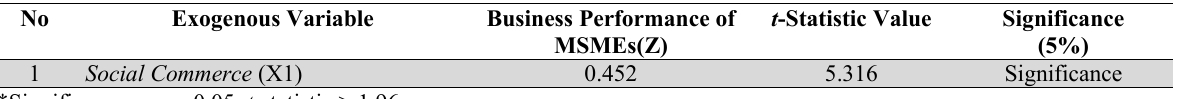
The indirect effect of Social Commerce, Uniqueness of Resource Capability, Competitive Advantages on Business